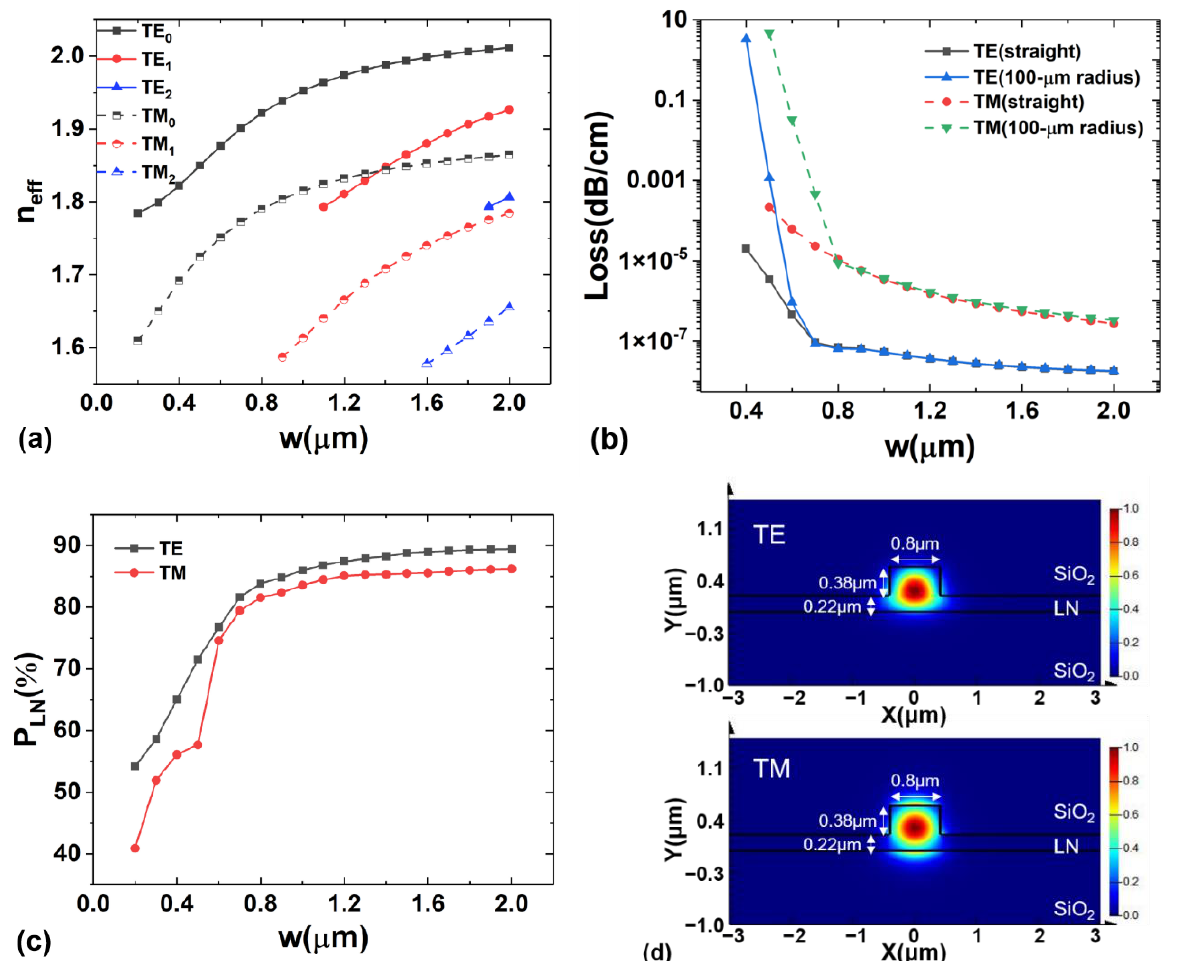
Figure 3. Dependence of ( a ) effective refractive index ( b ) transmission loss of straight waveguide/100 μm radius curved waveguide and ( c ) optical power ratio in lithium niobate on waveguide width. ( d ) Simulated transverse electric (TE) and transverse magnetic™ optical mode-field profile of a LiNbO 3 ridge waveguide with 0.22 μm thickness of slab layer and 0.8 μm width of waveguide at 1550 nm. Material boundaries are indicated by the black solid lines.